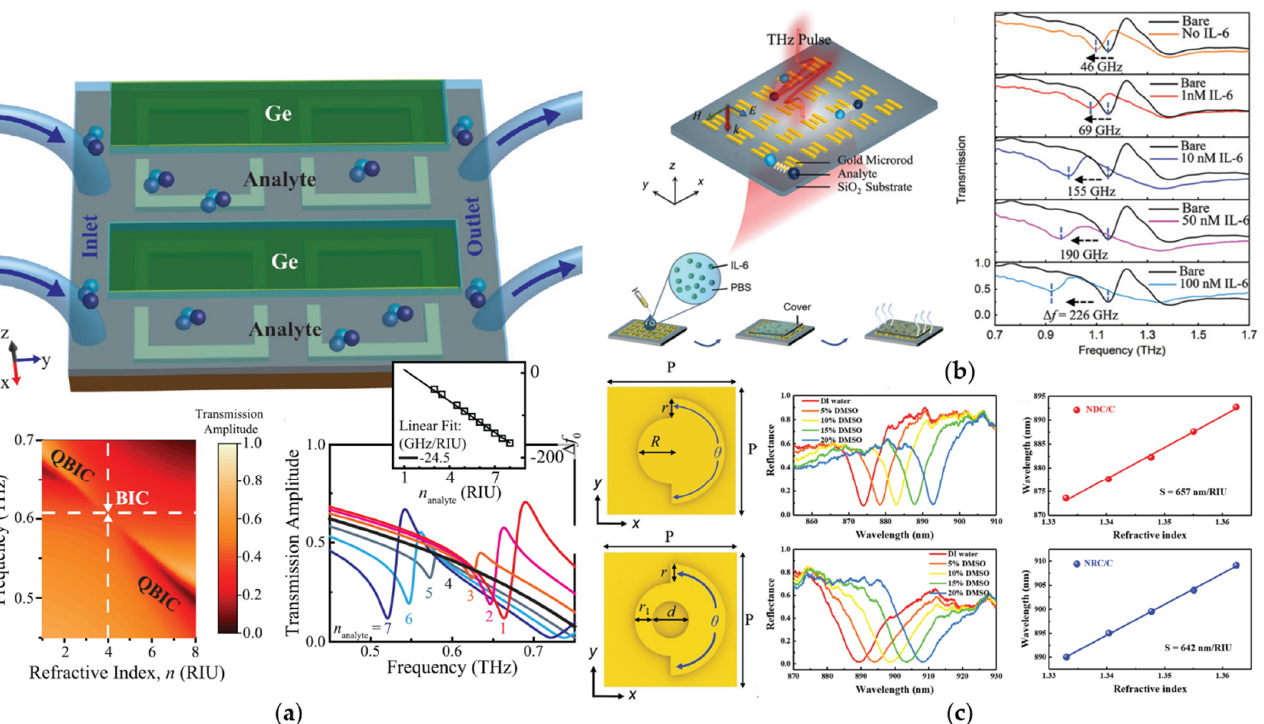
Figure 6. Metallic BIC biosensors. ( a ) A symmetry-broken golden THz metasurface coated with ger- manium strip and its bulk RI sensing ability (reprinted with permission from [94], ©2021, Wiley-VCH GmbH); ( b ) an ultra-sensitive THz metasurface utilized for biodetection of IL-6 (reprinted with permission from [95], ©2021, RSC); ( c ) a golden nano-metasurface with C-shaped edge and its